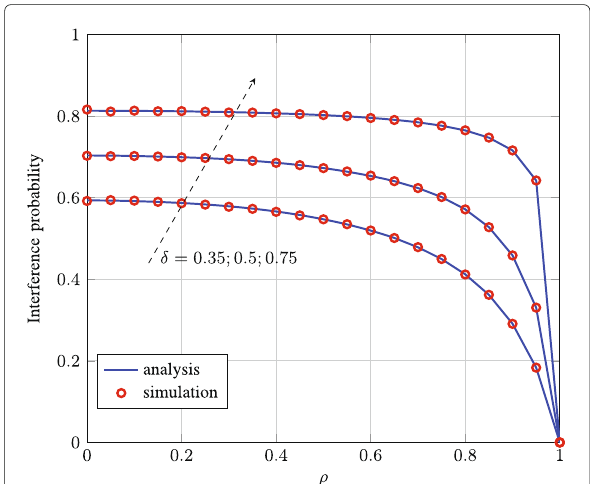
is revealed when the secondary transmitters adjust their power following the back-off power δ max .